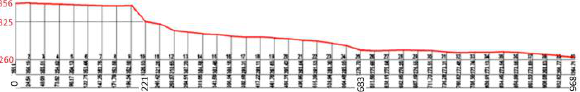
Figure 9.TIN of the landslide area